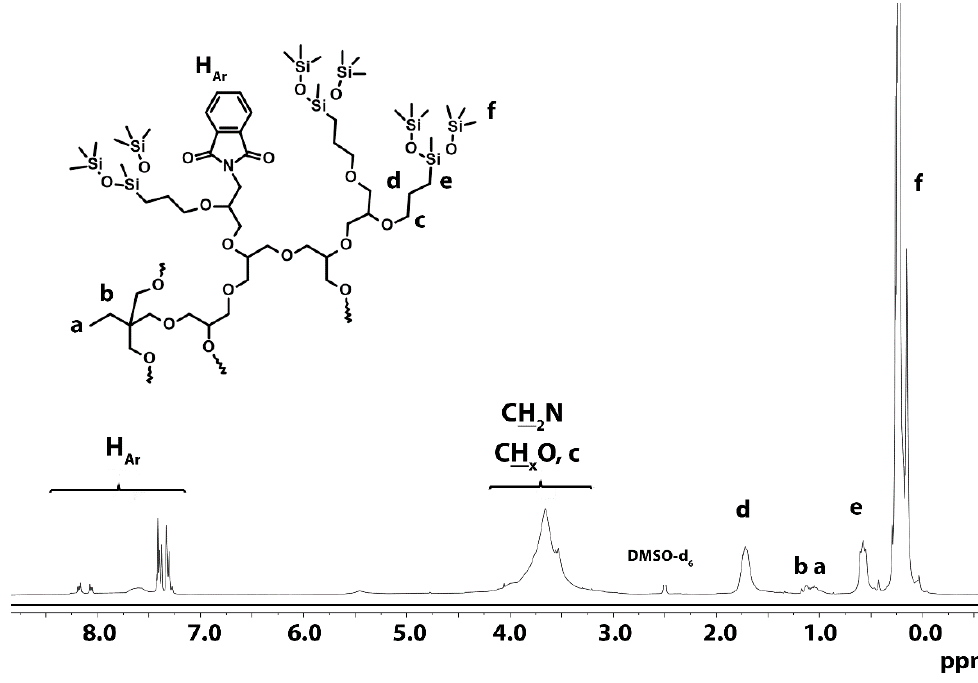
Figure 5. 1 H NMR (DMSO–d 6 , 500 MHz) spectrum of 3b copolymer.